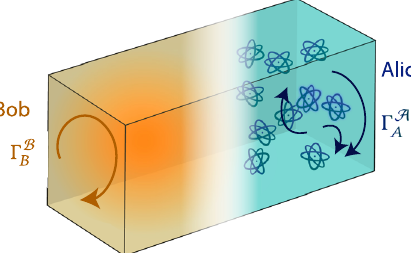
FIG. 4. Observers in thermodynamics. Alice has access to microscopic degrees of freedom of a gas, while Bob can only observe its coarse macroscopic properties, such as its temperature T , volume V , and pressure p . Alice describes the evolution of the gas using Gibbs-preserving maps, with a Gibbs state Γ A on the A full state space of the many particles of the gas. On the other hand, Bob describes the gas using his own knowledge — for instance, the macroscopic variables T , V , p — which, in full generality, we can represent as a quantum state in a state space H , which is obtained by applying a given mapping F A → B ð · Þ on B A → B Alice ’ s state. (For instance, this map may trace out the inacces- sible microscopic information.) States of the gas described by Bob may be transformed to Alice ’ s picture by applying a suitable recovery map, such as the Petz map [77,112 – 116]. Then, Alice ’ s Γ A -preserving maps appear to Bob as Γ B -preserving maps, where B A operator is taken to be Γ B Bob ’ s Γ B ¼ F A → B ð Γ A Þ . Conversely, B B A → B A operations that preserve Γ B for Bob may be described by Alice as B preserving Γ A A